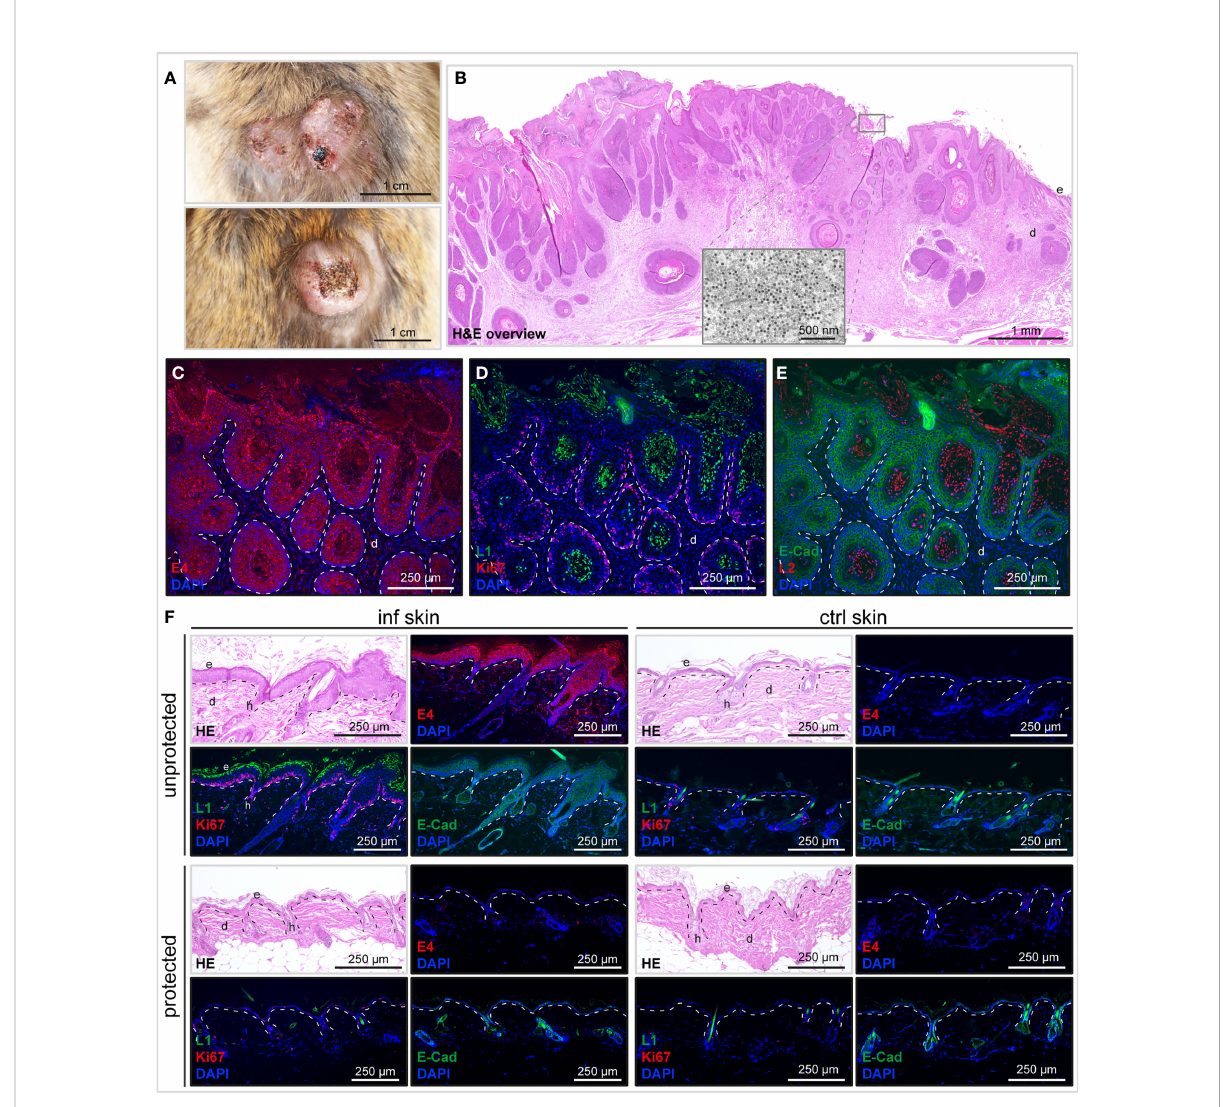
FIGURE 6 Histological characterization of MnPV-induced skin changes and tumor development. (A) Representative benign MnPV-induced skin tumors after experimental infection of unprotected animals. (B) HE staining of a benign MnPV-induced papilloma from the PBS control group. Virus progeny can be found in the keratinized outermost layer by transmission electron microscopy (TEM; inset). (C) Visualization of MnPV early gene expression by staining of MnPV E4 (red). (D) Proliferation rates are elevated in corresponding areas as indicated by Ki67 positive cells (red). Viral capsid components can be detected by staining of MnPV L1 (green) or (E) MnPV L2 (red). E-cadherin (green) staining was used to reveal the epidermal origin of infected cells. (F) Representative tissue stainings of unprotected and protected vaccinated animals. Experimentally infected ( ‘ inf ’ ) and uninfected control ( ‘ ctrl ’ ) skin of the same animals was Hematoxylin-Eosin (HE) stained or subjected to immuno fl uorescence (IF) for staining of MnPV E4 or Ki67 (both red), L1 or E-cadherin (both green). Nuclei were stained with DAPI